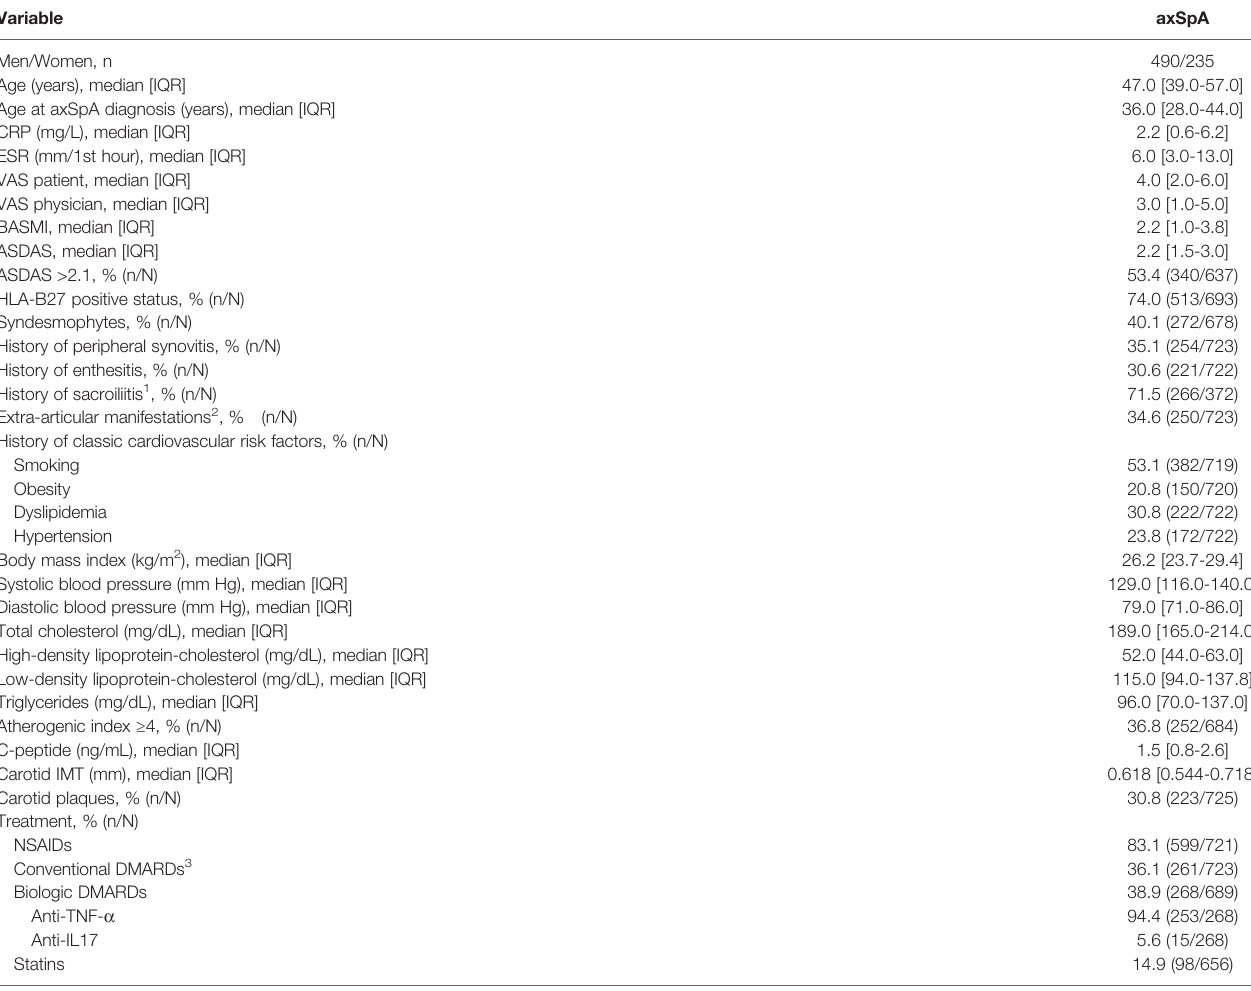
TABLE 1 | Demographic, clinical and cardiovascular disease-related characteristics in patients with axSpA.